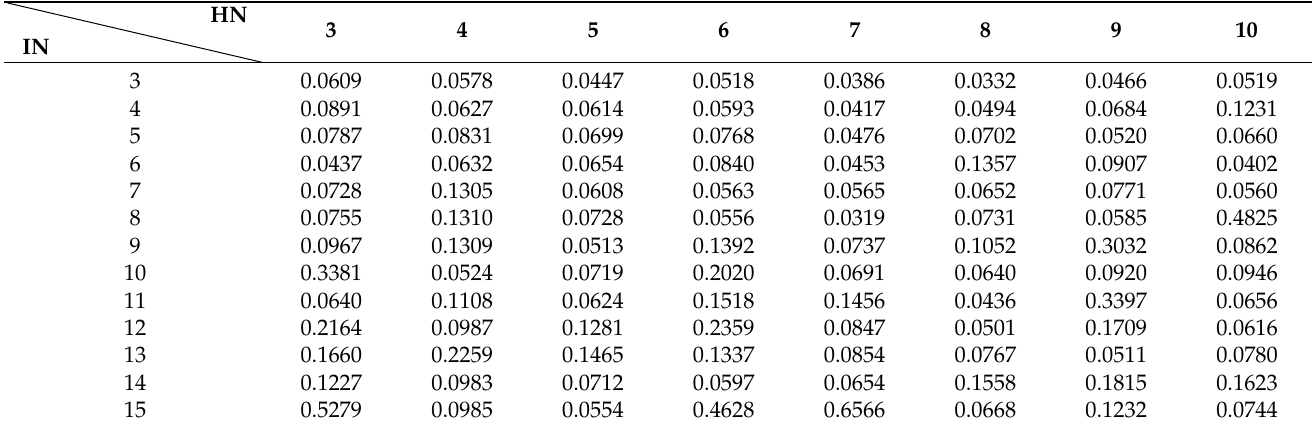
Table 6. MSE of different nodes between input and hidden layer.